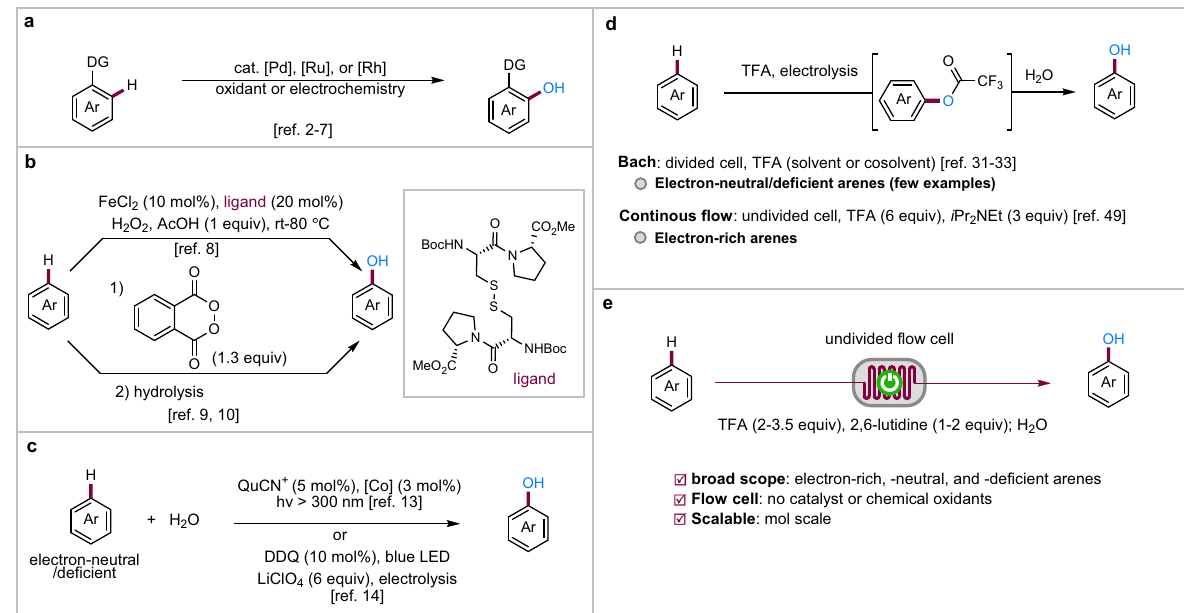
Fig. 1 C – H hydroxylation of arenes. a Transition metal-catalyzed C – H hydroxylation with directing groups. b C – H hydroxylation employing peroxides. c Photocatalytic/electrophotocatalytic hydroxylation of arenes. d Electrochemical hydroxylation of arenes. e Electrochemical hydroxylation of arenes of in continuous fl ow (this work). DG directing group, QuCN + 3-cyano-1-methylquinolinium ion, DDQ 2,3-dichloro-5,6-dicyanobenzoquinone, TFA tri fl uoroacetic